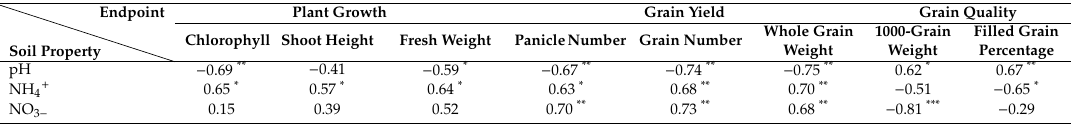
Table 3. Pearson correlation coe ffi cient 1 ( r ) between selected soil properties at the 4th week and the endpoint of rice at the 20th